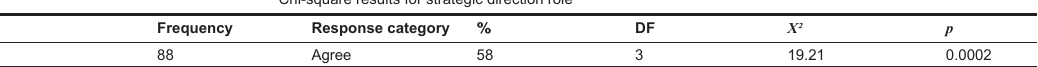
Table 3 Chi-square results for strategic direction role